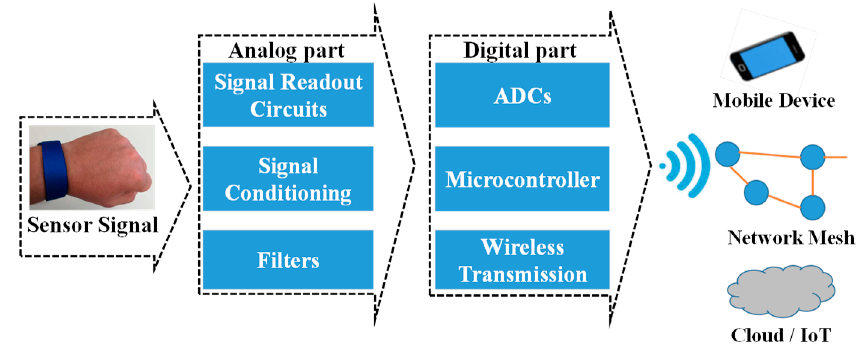
Figure 3. Signal flow diagram for measuring an entity through wearable sensors and data transmission.